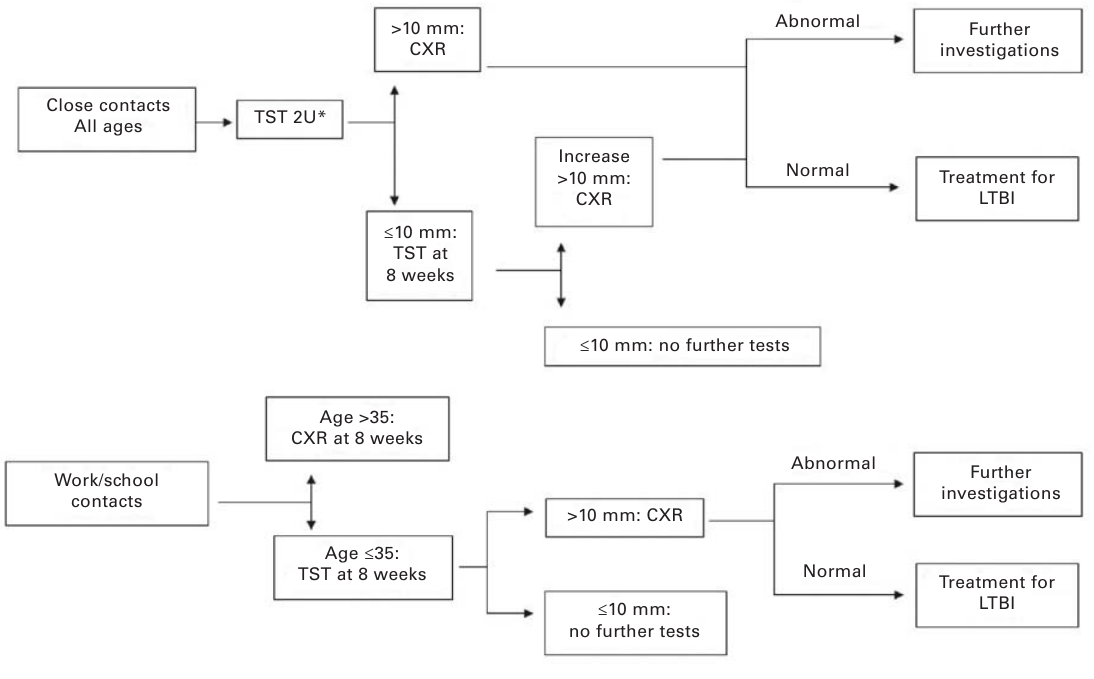
Algorithm used for contact tracing dur- ing study period (Jan 1993–dec 2002). TST:Tuberculin skin test; CXR: Chest X-ray; lTBi: latent tuberculosis